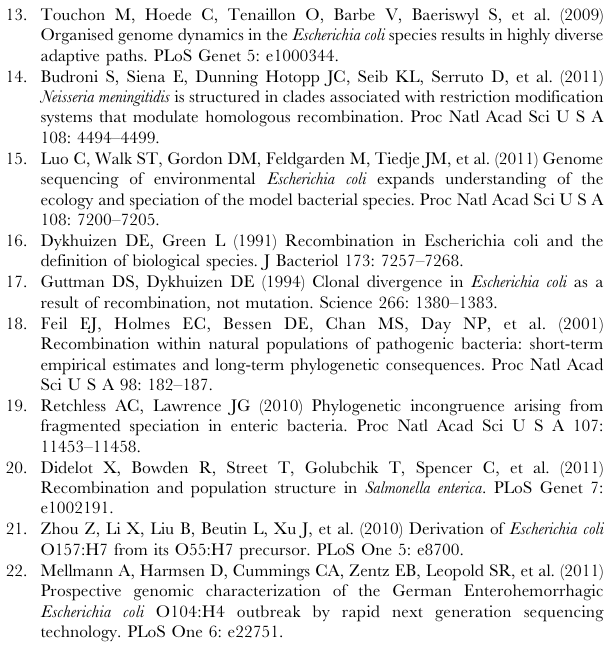
Figure S1 Recombinant genes and regions associated with prophages. Clade-specific recombination (either in ON2010-55989, or in ON2011-01-09591, see text for detailed discussion) is colored in magenta. Figure S2 Maximum likelihood phylogenetic tree of the 57 Escherichia coli and Shigella strains as reconstructed from the sequences of 2013 universally present single- copy genes (1890550 characters in total, after the removal of 70 recombinant genes). E. fergusonii was chosen to root the tree. Three internal branches that are not well supported (with a bootstrap value , 90) are labeled as asterisks.